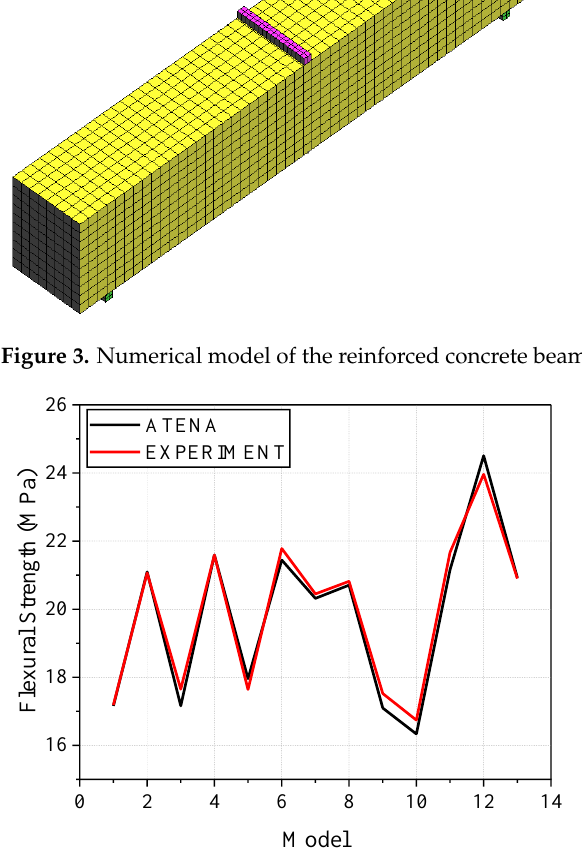
Figure 3. Numerical model of the reinforced concrete beam (M8).